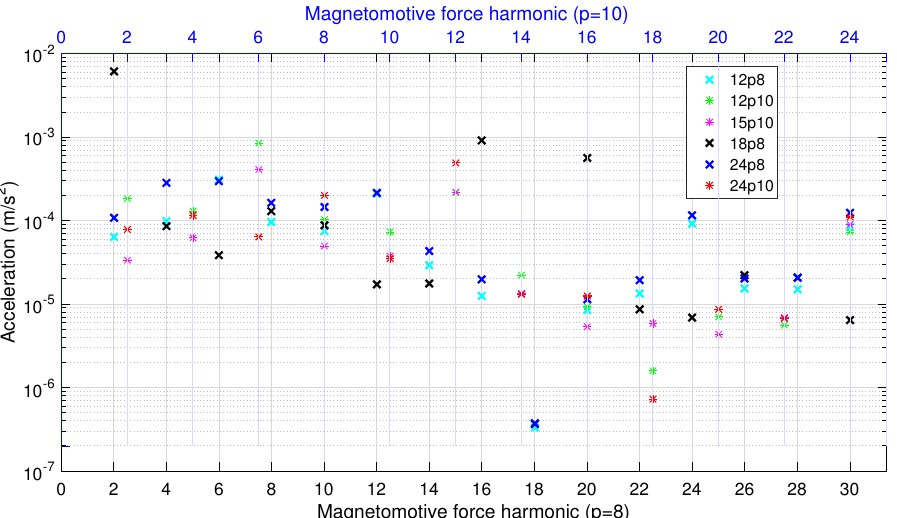
Figure 9. Comparison of the vibration response of machines of several numbers of poles and